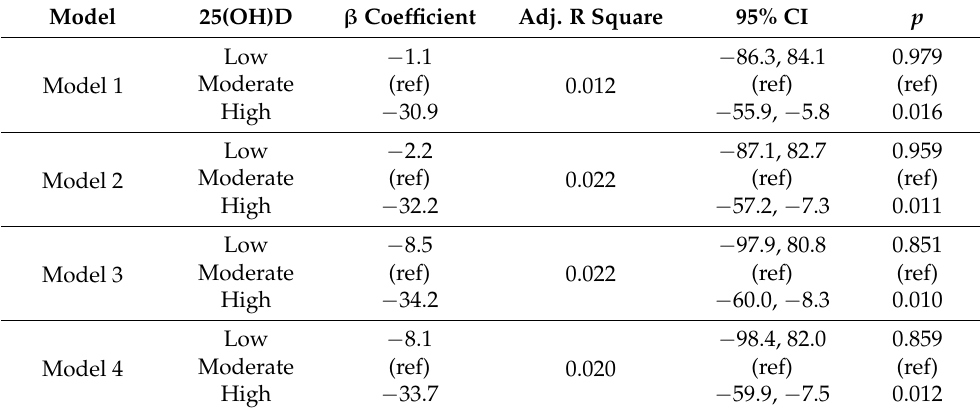
Figure 3. The association between 25(OH)D concentration and telomere length at 18 months in the Newcastle 85+ Study . Table 4. Association between 25(OH)D cut-offs and telomere length at 18 months. Table 4. Association between 25(OH)D cut-offs and telomere length at 18